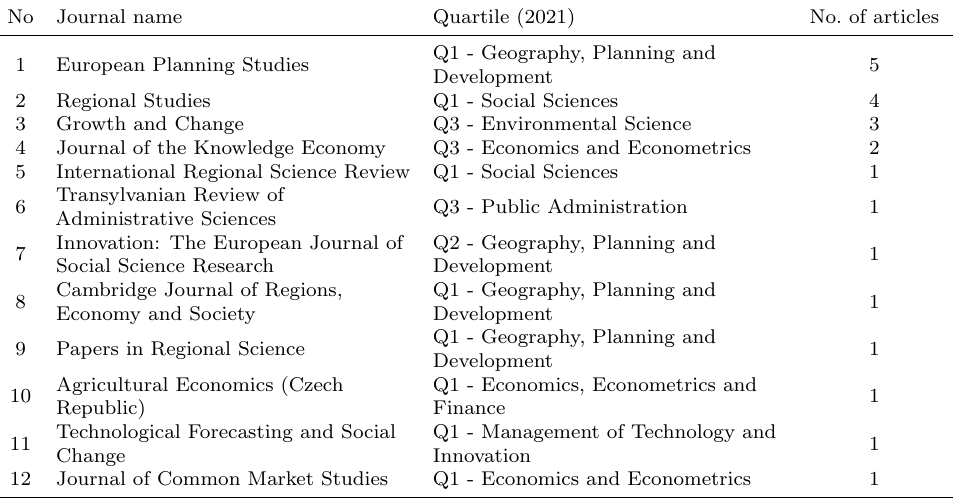
Table 3: List of publication